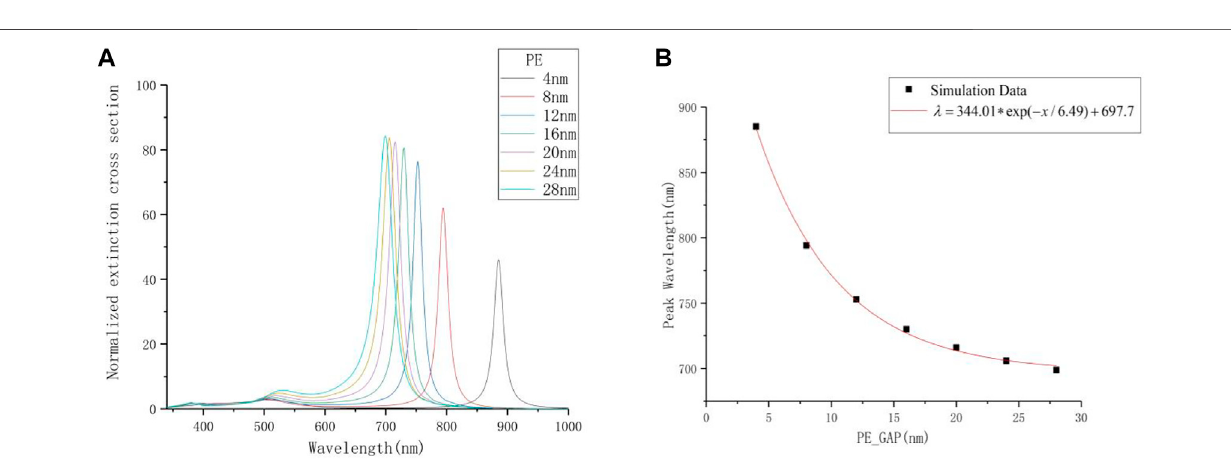
Frontiers in Chemistry |